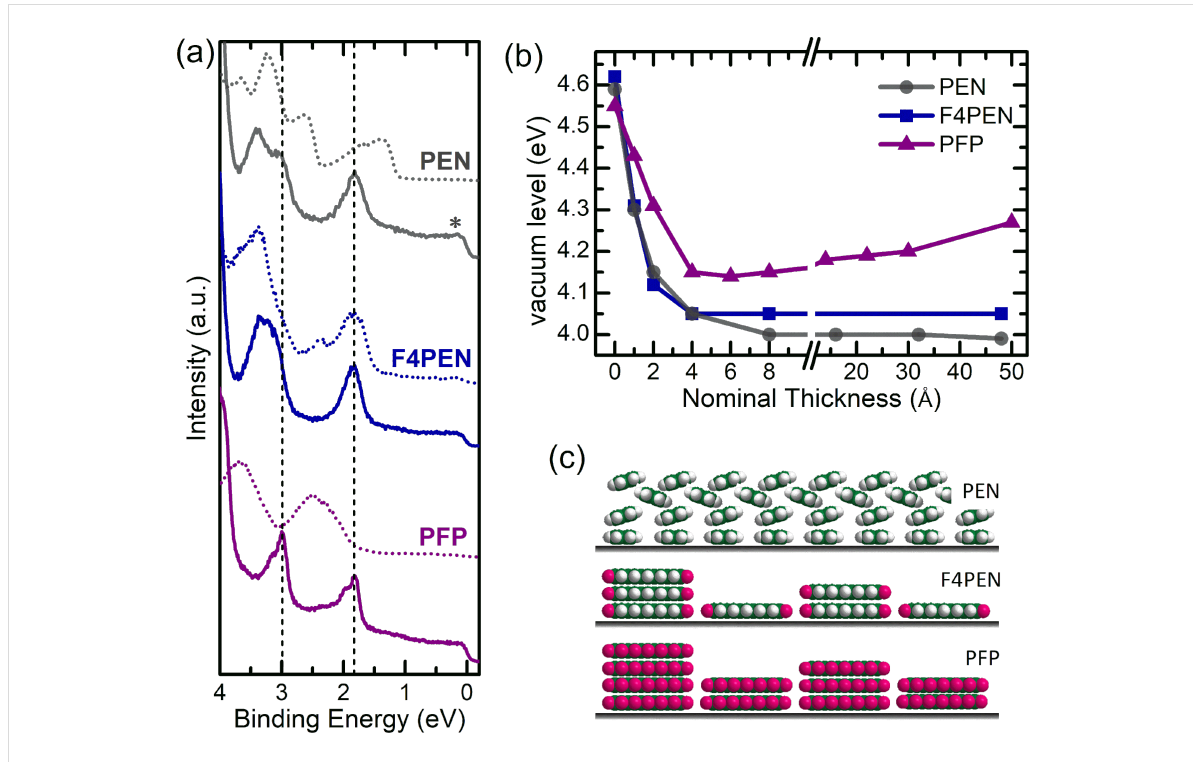
Figure 3: (a) Valence band spectra for (fluorinated) pentacene in (sub)monolayer (solid lines) and multilayer (dotted lines) thin films on Ag(111). (b) Evolution of the vacuum level of (fluorinated) pentacene with increasing thickness on Ag(111). The PEN and PFP data in (a) and (b) is taken from [28,50]. (c) Hypothetical growth modes of (fluorinated) pentacene on Ag(111) on profile view, with the C atoms in green, the F atoms in red and the H atoms in grey. Note, that PEN (F4PEN and PFP) is viewed along the short (long) molecular axis. A more detailed discussion on the F4PEN adsorp- tion geometry on Ag(111) based on the analysis of the f H values can be found in Supporting Information File 1, Figure